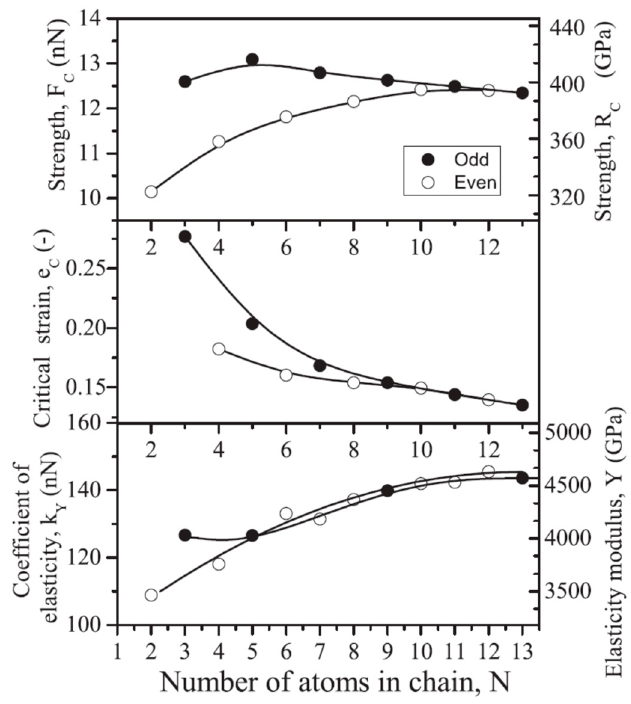
Figure 4. The dependence of the strength F c , fragility e c , and hardness k Y on the number of atoms in carbyne. Reproduced with permission from [2].